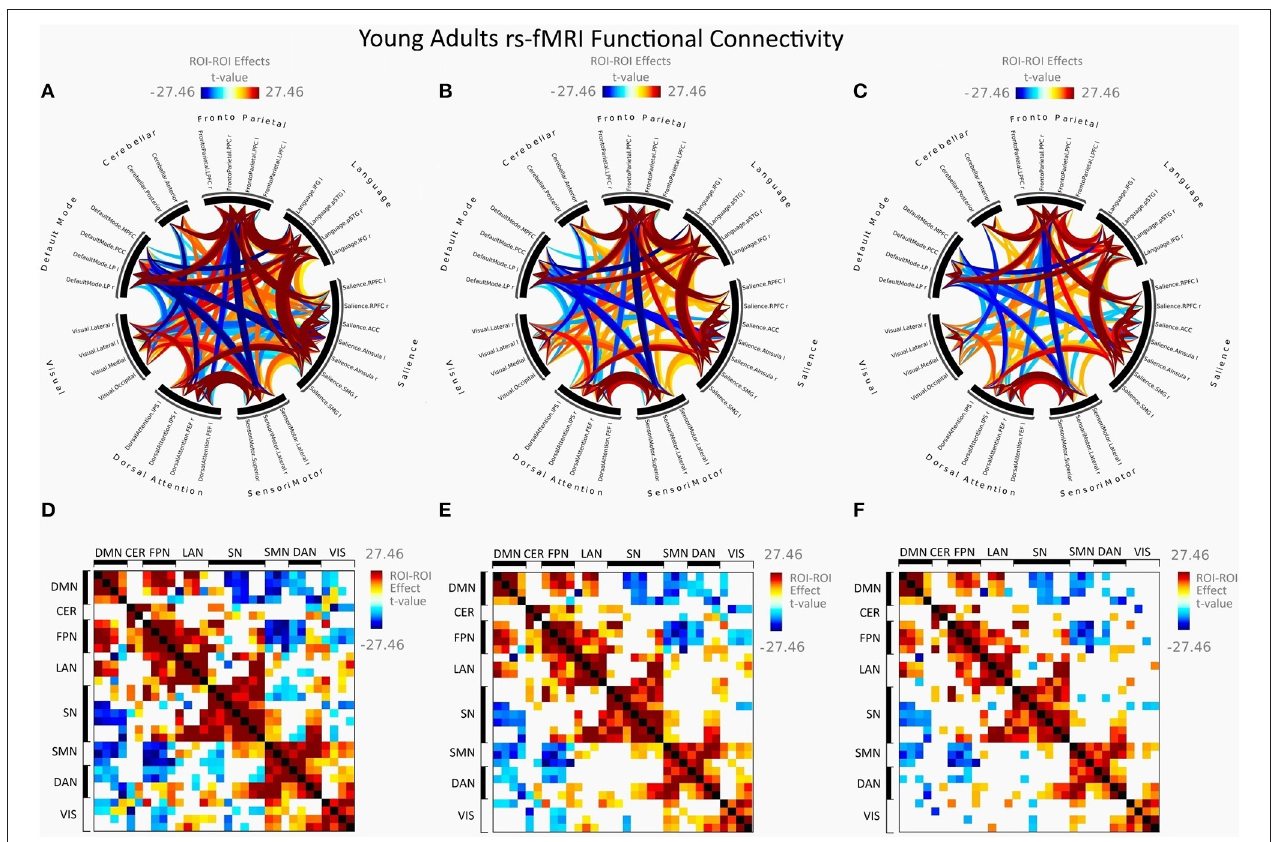
FIGURE 2 | Mean FC in female young adults presented as a connectome ring and a connectivity matrix showing nodes with increased FC (red) and decreased FC (blue). Connectome ring network correlations computed using: (A) Functional network connectivity (FNC). (B) Spatial pairwise clustering (SPC). (C) Network-based statistics (NBS). Connectome matrix network correlations computed using: (D) Functional network connectivity (FNC). (E) Spatial pairwise clustering (SPC). (F) Network-based statistics